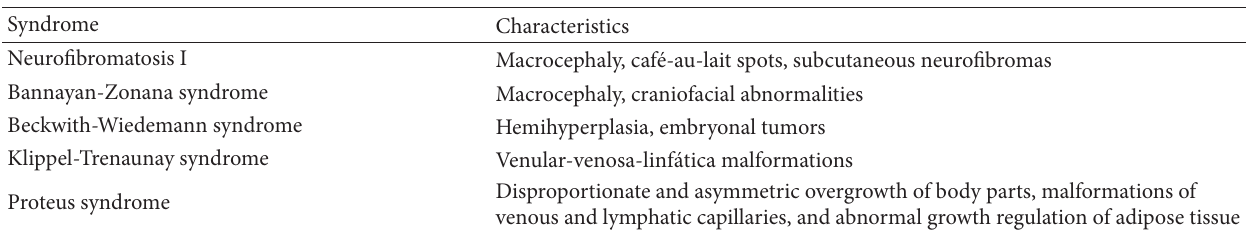
Table 2: Differential